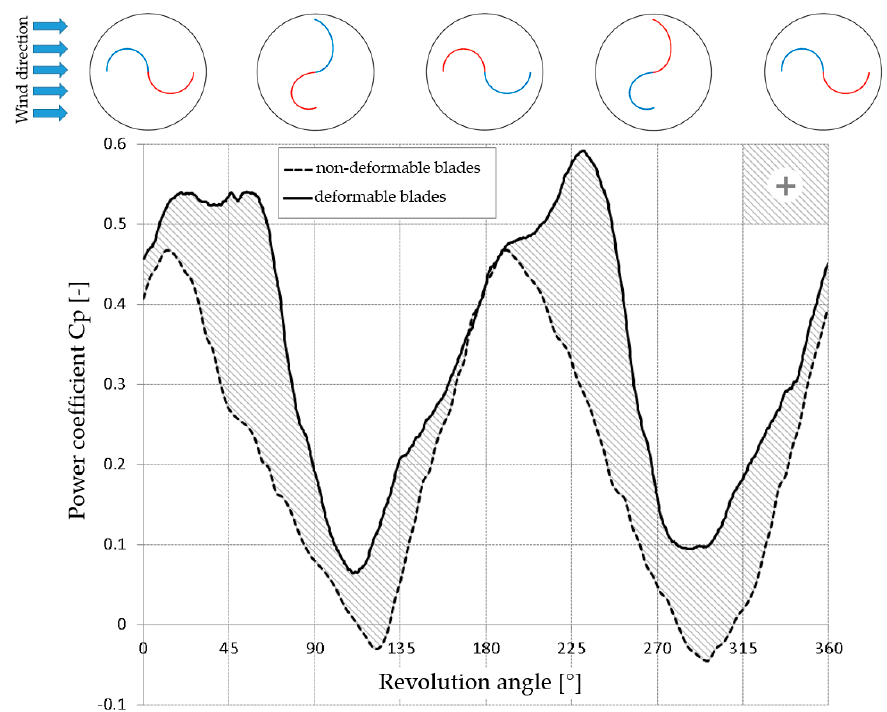
Figure 8. Comparison of the averaged values of the power coefficient Cp for one revolution of the rotors with non-deformable and deformable blades. Subsequent positions of the turbine illustrated in the schemes above the graph correspond to the turbine revolution angle.